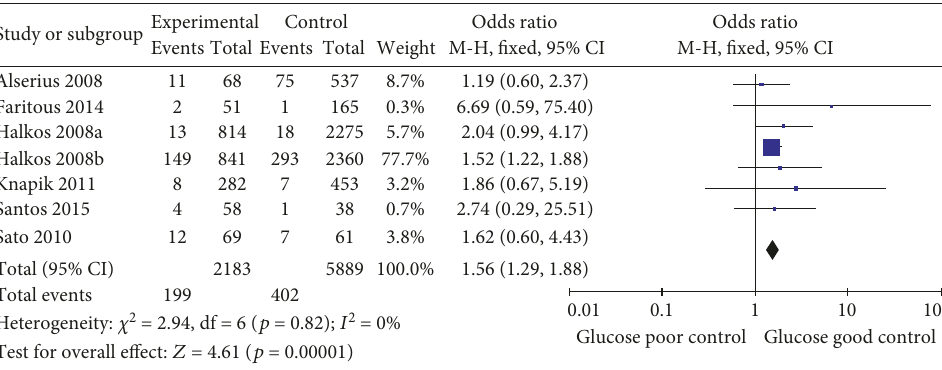
Figure 3: Forest plot of the relationship between HbA1c level and myocardial infarction.